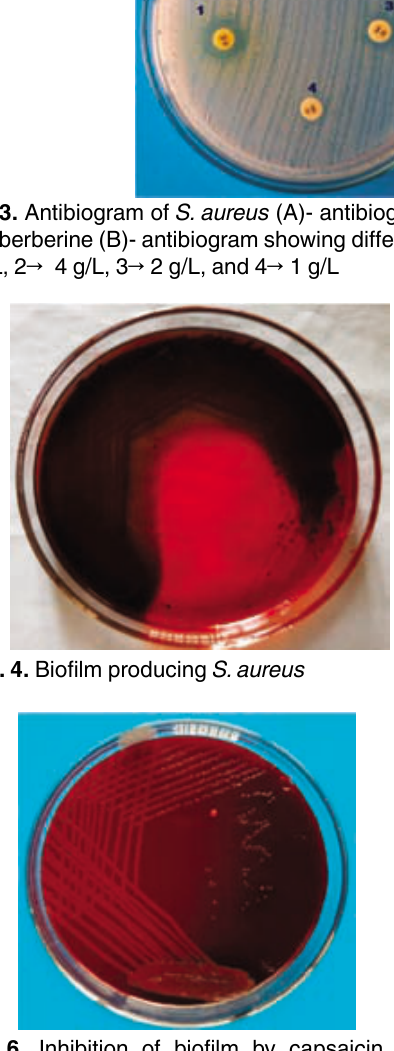
258 Antibiofilm activity of berberine and capsaicin in combination with quinolones against S taphylococcus aureus from bovine